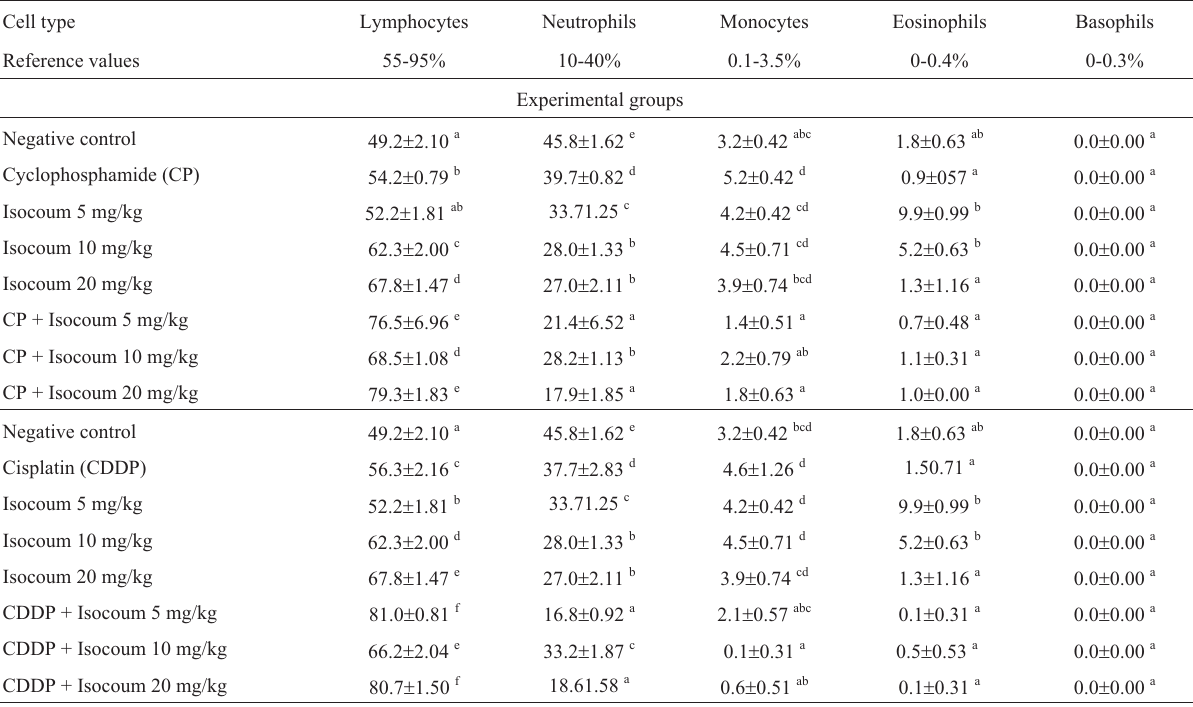
Table 6 - Reference values and mean (cid:5) SE of the differential blood cell count in Swiss mice treated with different doses of isocoumarin. Cell